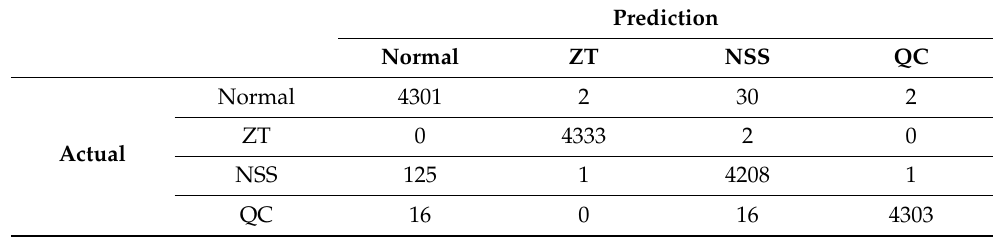
Table 11. Confusion matrix for the multiclass case.